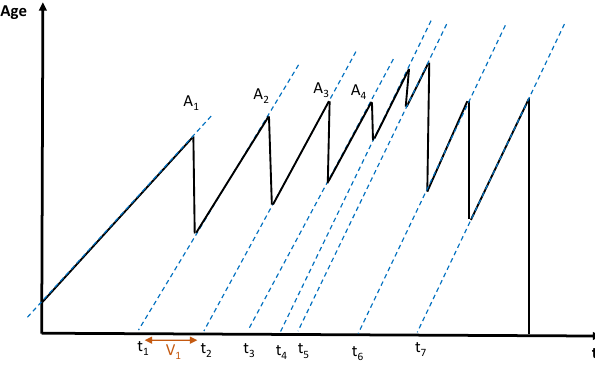
Figure 5. A sample of the evolution of AoI over